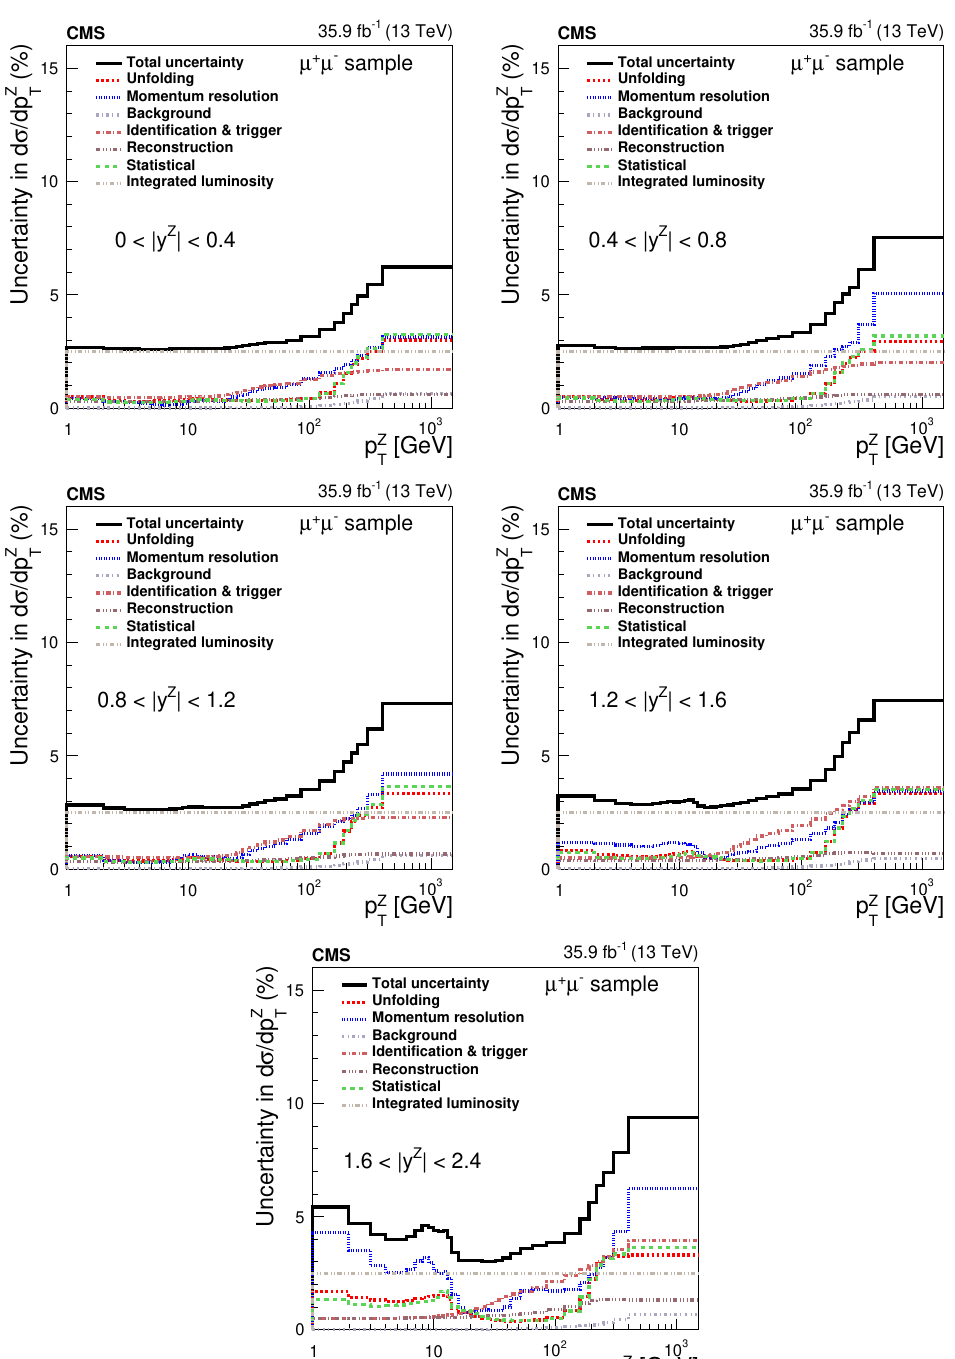
Figure 3 . The relative statistical and systematic uncertainties from various sources for the absolute double-di(cid:11)erential cross section measurements in bins of p Z for the 0 : 0 < j y Z j < 0 : 4 bin (upper T left), 0 : 4 < j y Z j < 0 : 8 bin (upper right), 0 : 8 < j y Z j < 1 : 2 bin (middle left), 1 : 2 < j y Z j < 1 : 6 bin (middle right), and 1 : 6 < j y Z j < 2 : 4 bin (lower) in the dimuon (cid:12)nal state.